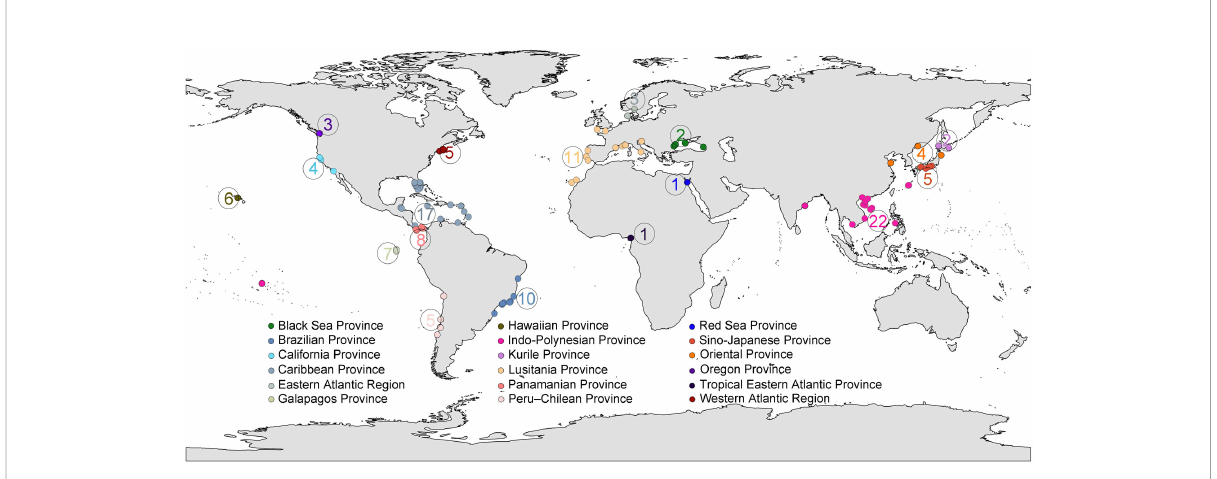
FIGURE 11 Global distribution of Ototyphlonemertes . Color codes represent different marine biogeographic provinces as de fi ned by Briggs and Bowen (2012). The circled number is the number of species/entities in each biogeographic